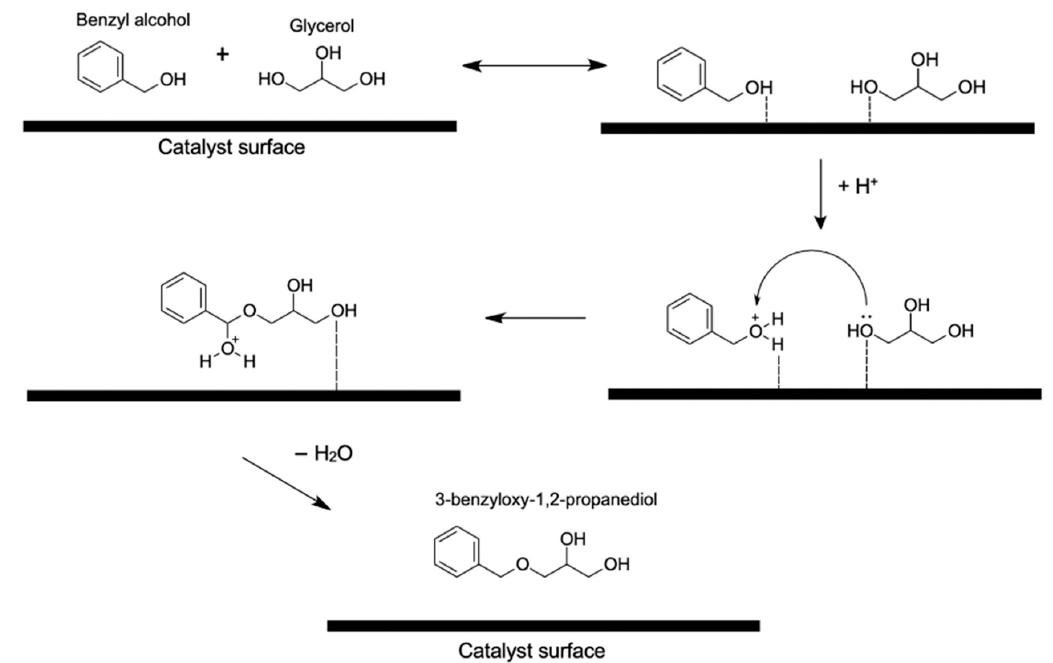
Figure 12. Undesired side reaction using benzyl alcohol as reactant [99].